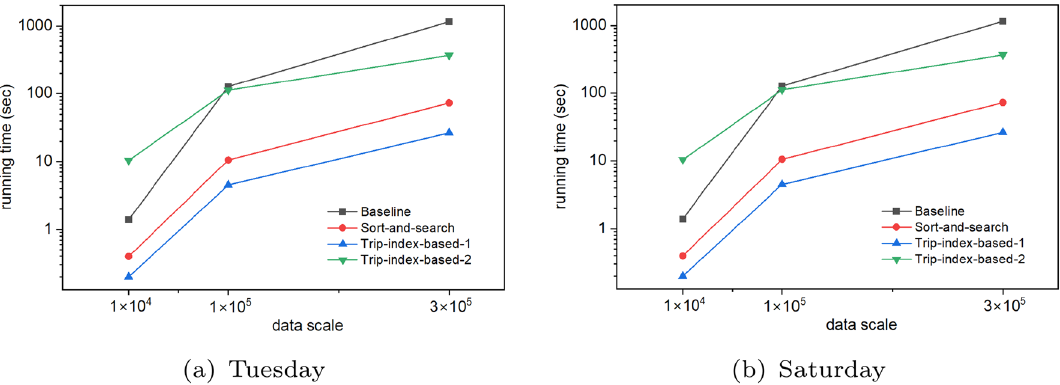
Fig. 16 Running time of finding out tight follow-up trips